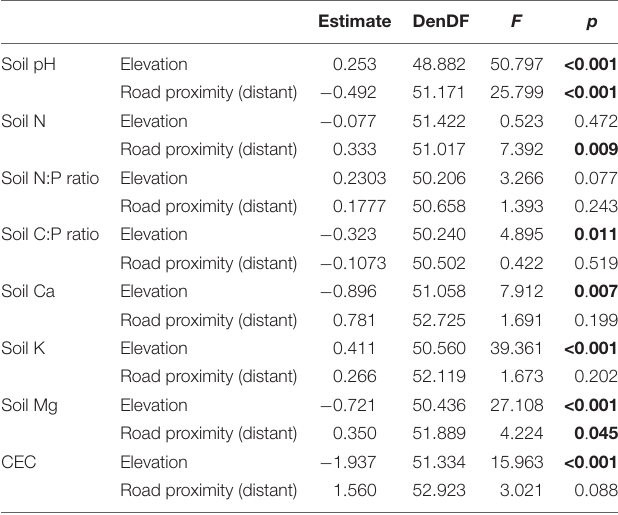
TABLE 1 | Results from linear mixed-effects models to analyze the effects of elevation and road proximity (roadside or distant plot) on chemical soil properties. Estimate DenDF